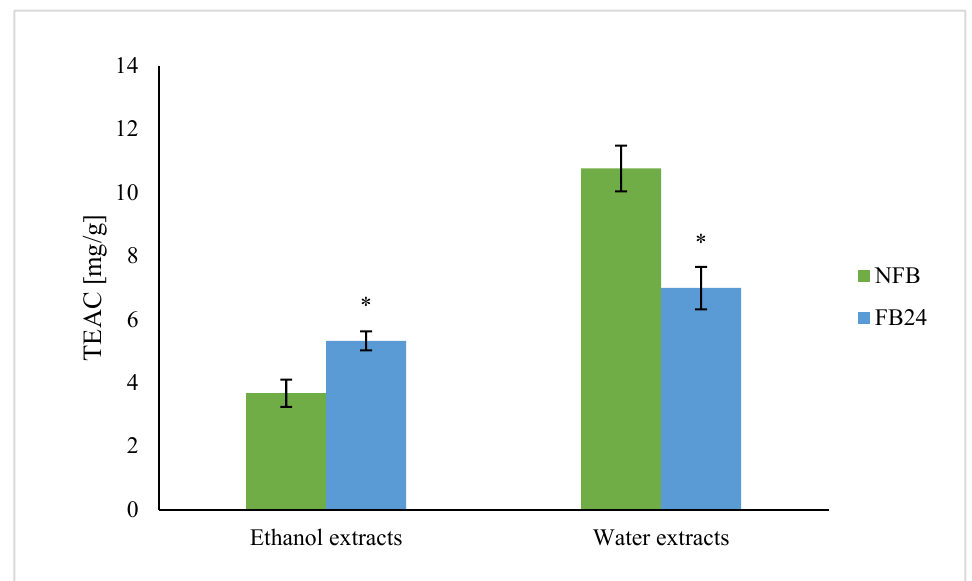
Figure 4. Trolox equivalent antioxidant activity (TEAC) of water and ethanol extracts of non-fermented broth (NFB) and fermented A. platensis broth (FB). Data represent mean values ± SD. Asterisk (*) indicates statistically significant difference between FB and NFB for particular extract ( p < 0.05).